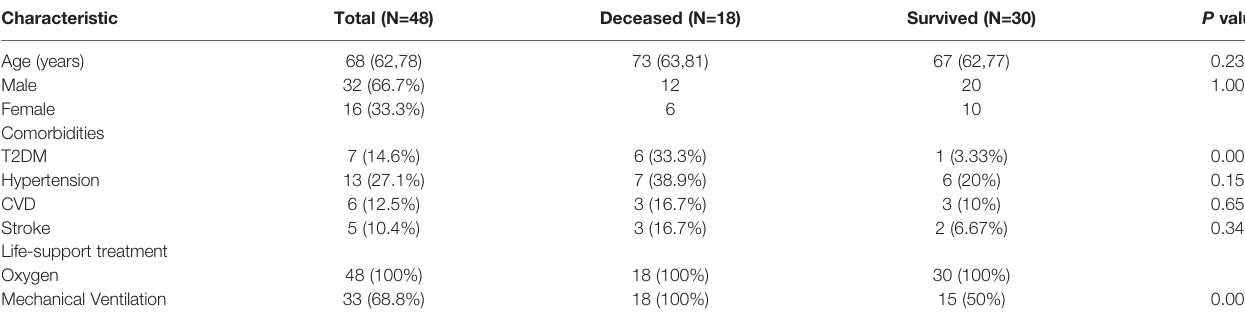
TABLE 1 | Demographic and clinical characteristics of critical patients with